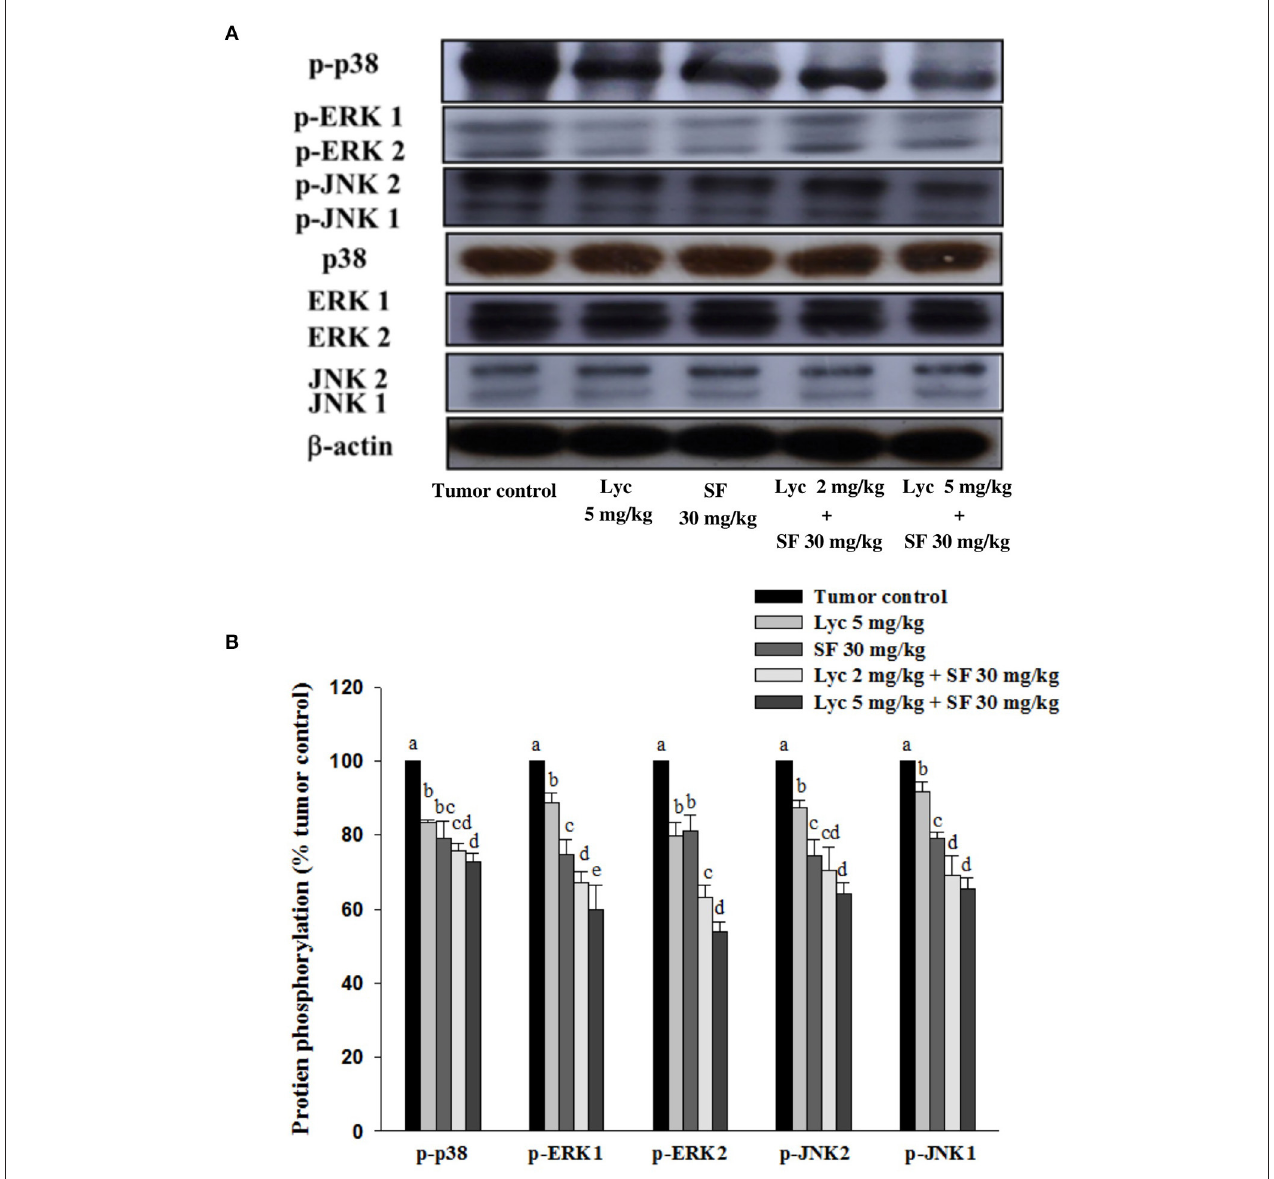
FIGURE 6 | Effects of lycopene (Lyc) alone, sorafenib (SF) alone, or their combination on the phosphorylation of p38, ERK1/2 and JNK1/2 proteins in lung tissues of the C57BL/6 mice xenografted LLC cells. Nine days after tumor cell injection, the mice were orally supplemented with SF (30 mg/kg) daily, Lyc (5 mg/kg) twice per week or the combined treatment (mice were supplemented with SF (30 mg/kg) daily, and Lyc (2 and 5 mg/kg) twice per week) for 28 days. (A) Western blot analysis of p-p38, p38, p-ERK1/2, ERK1/2, p-JNK1/2, JNK1/2 and -actin. (B) Quantitative results of the protein phosphorylation of p38, ERK1/2, and JNK1/2. Data are means ± SD, n = 7 – 8; values not sharing an alphabetic letter are significantly different ( P < 0.05).